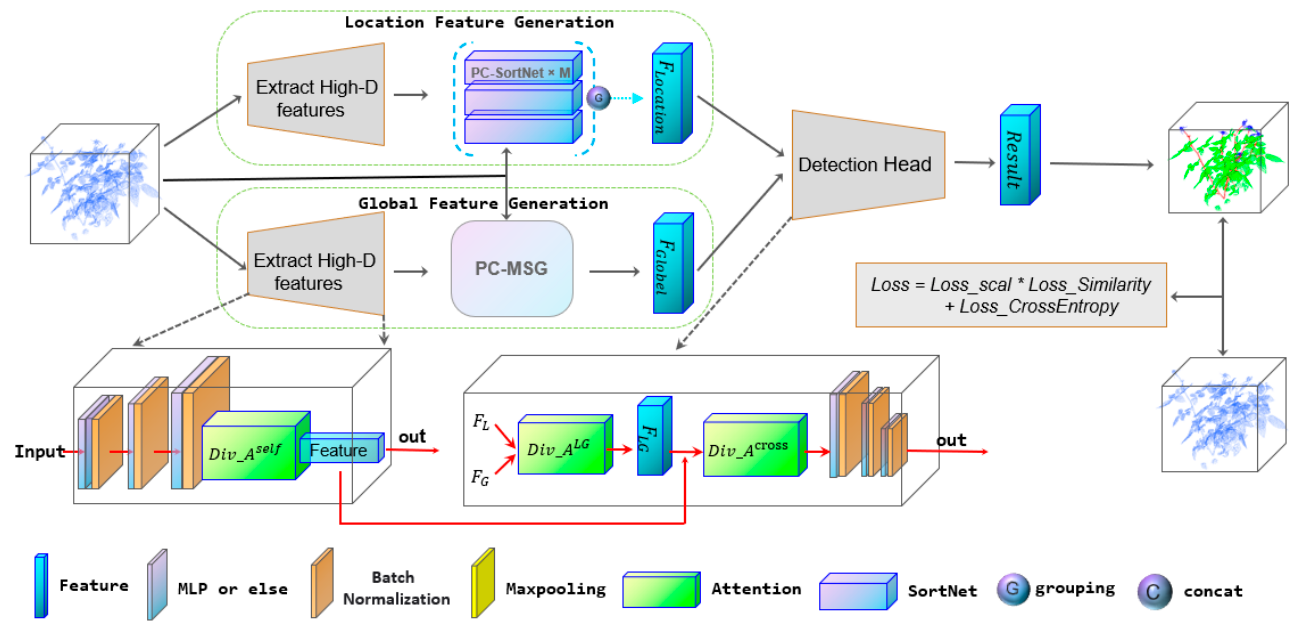
Figure 1. Architecture of MASPC_Transform.